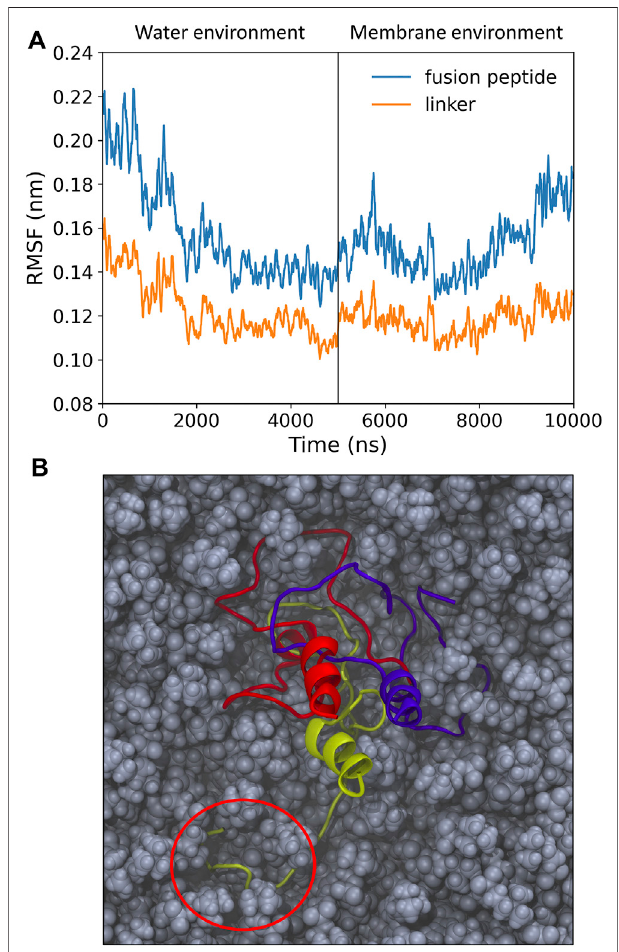
FIGURE 3 | (A) Root mean square fl uctuation (RMSF) of C α atoms over 5 ns windows for pillow-like hydrophobic assembly in water and following its insertion to membrane environment. (B) Simulation snapshot with disrupted pillow structurewithinlipidenvironment.CircleindicatesaliberatedHAfp with initial secondary